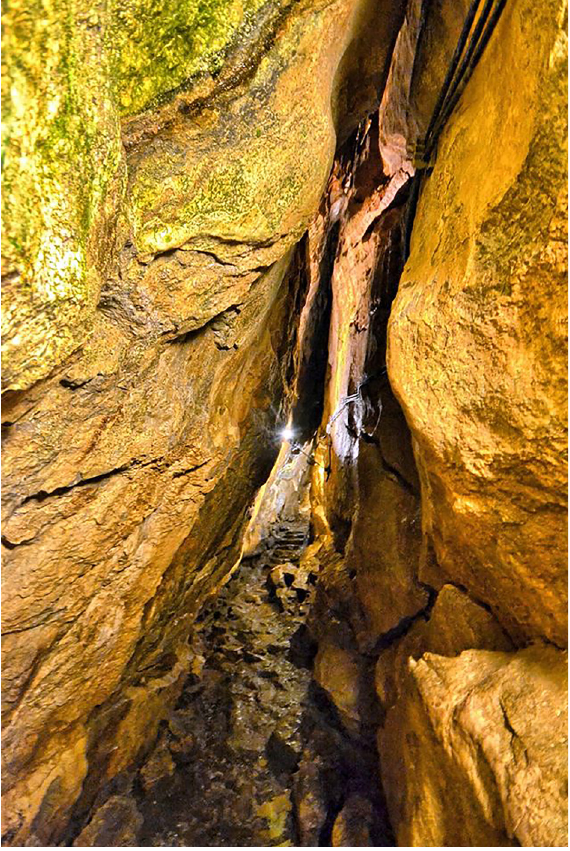
Fig. 5. White Passage (fractured corridor) in the Mroźna Cave (photo Zb.Zwoliński